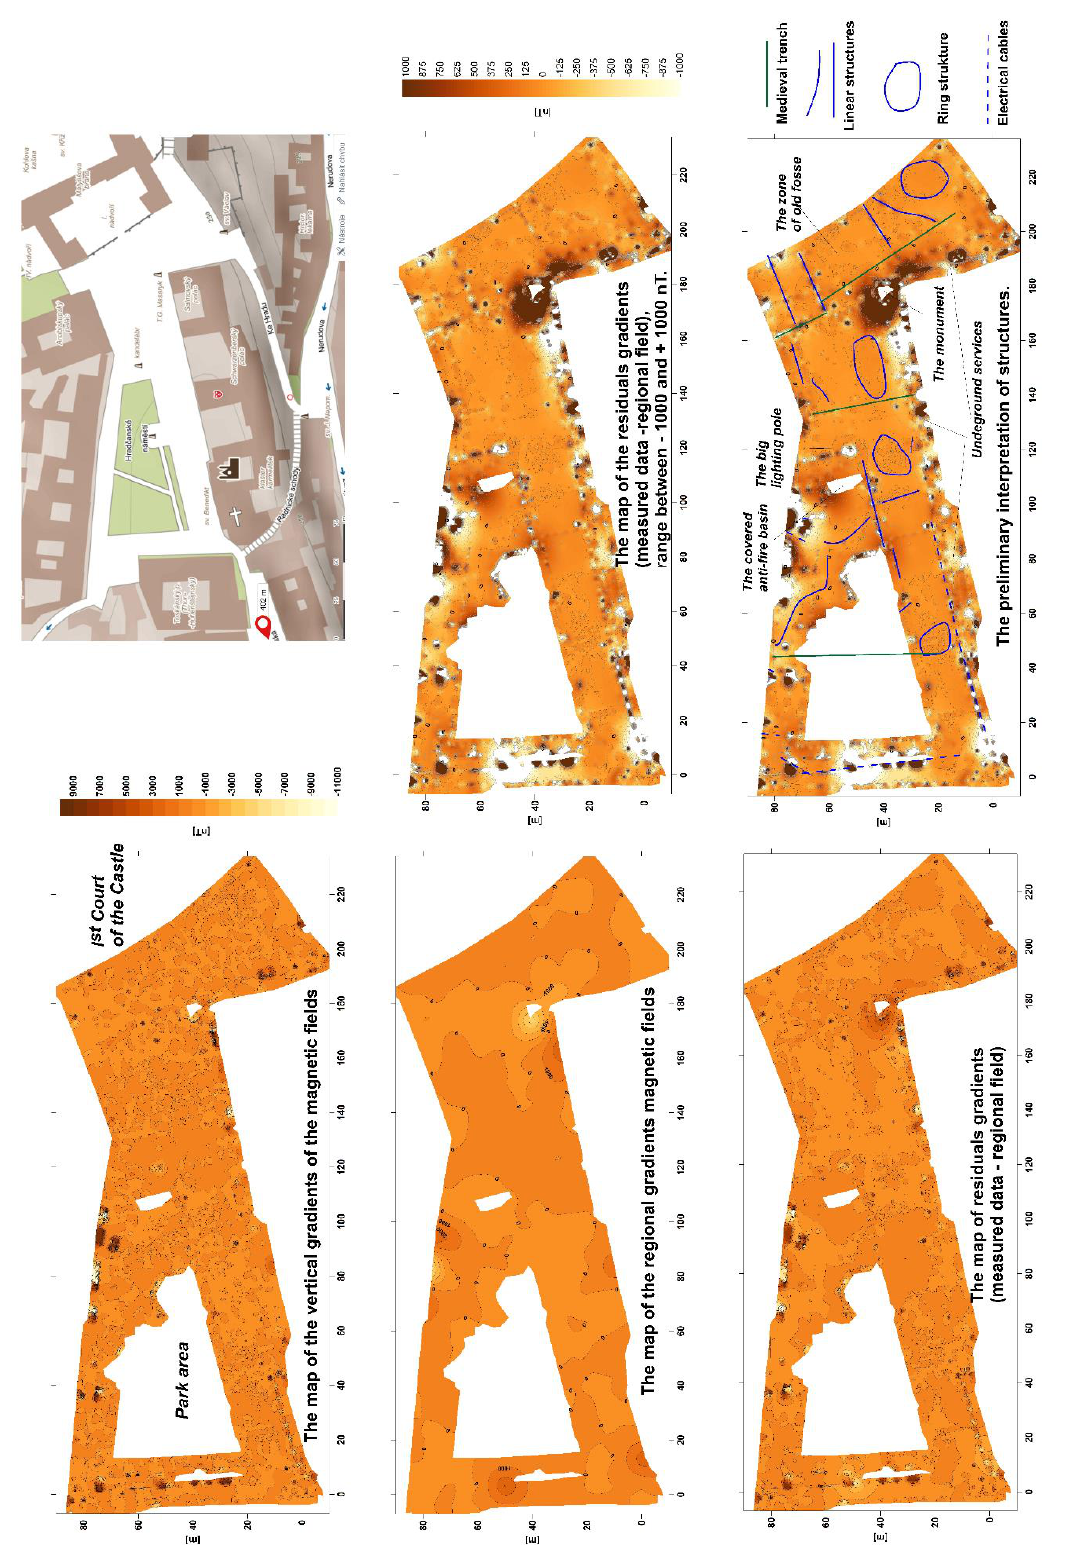
Figure 24. Hračany Square. The analysis of the magnetic measurements and preliminary Figure 24. Hraˇcany Square. The analysis of the magnetic measurements and preliminary interpretation.